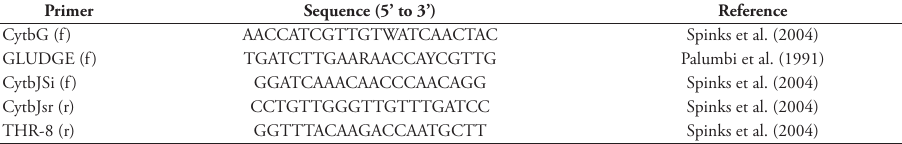
Table 2. Primers used in this